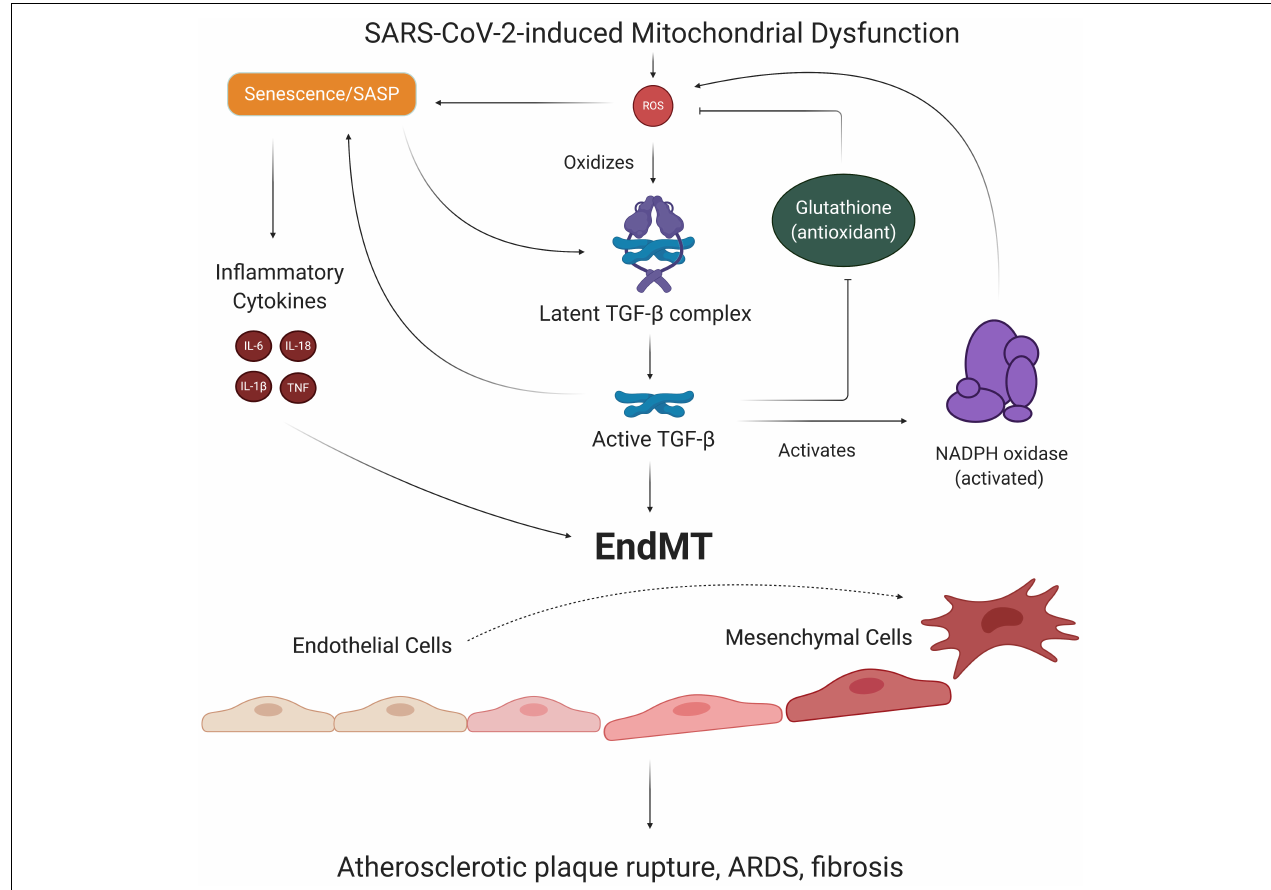
FIGURE 6 | EndMT’s role in SARS-CoV-2-induced feedback loops. ECs with SARS-CoV-2-induced SASP secrete TGF- β , a growth factor known to promote the transition of ECs to mesenchymal, fibroblast-like cells. Oxidative stress is responsible for activating TGF- β , which activates Smad transcription factors that further promote senescence and induction of EndMT. The process of EndMT results in rupture-prone atherosclerotic plaques, weakening of the endothelial barrier, and cardiac and pulmonary fibrosis. Notably, TGF- β exacerbates redox imbalance and oxidative stress by increasing Nox subunit expression and suppressing production of the antioxidant glutathione. Thus, TGF- β and associated EndMT may be key players in our suggested long-term consequences of SARS-CoV-2 infection. EndMT, endothelial to mesenchymal transition; SASP, senescence-associated secretory phenotype; TGF- β , transforming growth factor